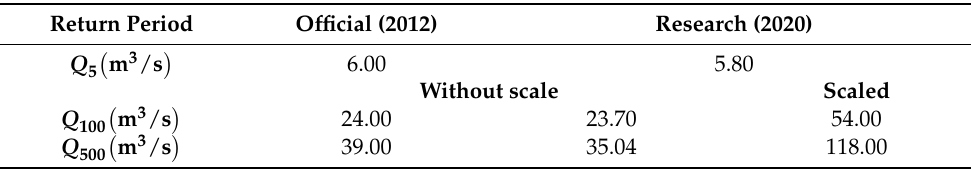
Table 7. Flow values: official values vs. research.